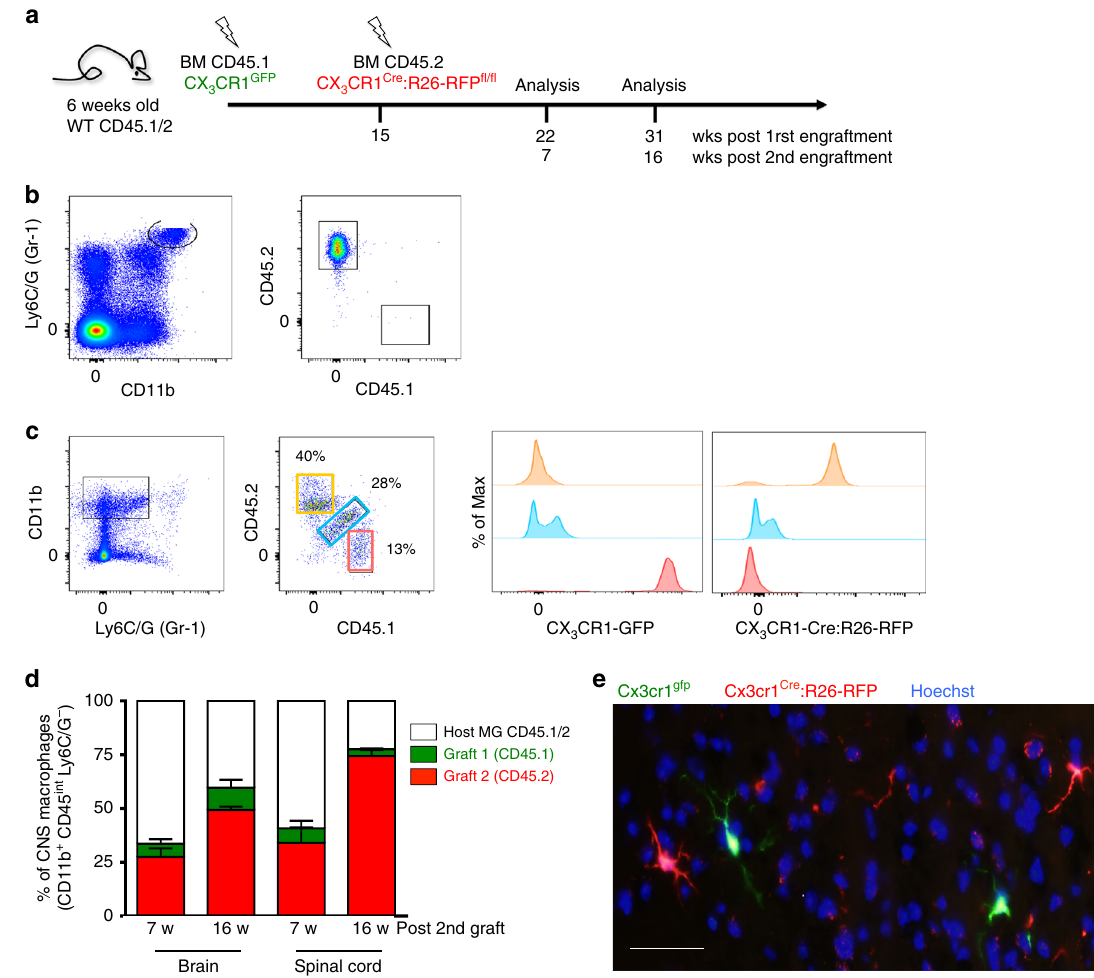
Fig. 1 Engrafted brain macrophages accumulate over time and self-maintain. a Schematic of tandem BM transfer protocol. b Flow cytometric blood monocyte analysis of chimera 16 weeks post second transplantation. c Flow cytometric analysis of myeloid brain cells 16 weeks post second BMT revealing host microglia (CD45.1/2 + , blue), cells derived from the fi rst graft (CD45.1 + GFP + , red) and cells derived from the second graft (CD45.2 + RFP + , orange). d Distribution of host and graft-derived cells out of the total Ly6C/G (Gr1) – CD45 lo CD11b + cells in brain and spinal cord at two time points. Data are a summary of six mice. e Histological analysis 7 weeks post second BMT revealing rami fi ed GFP + and RFP + cells with microglia morphology (scale bar 20 μ m). Representative